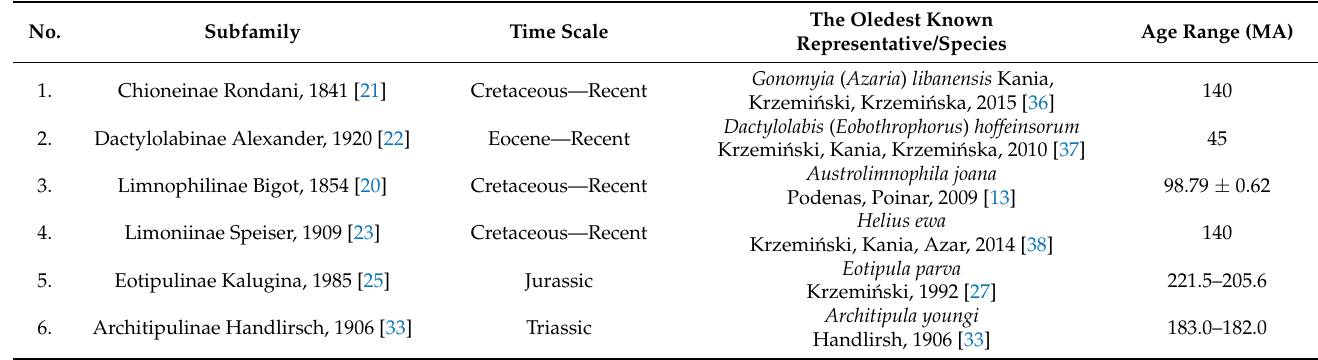
Table 1. A list of subfamilies of family Limoniidae, known till know (the age range follows that in the descriptions cited).